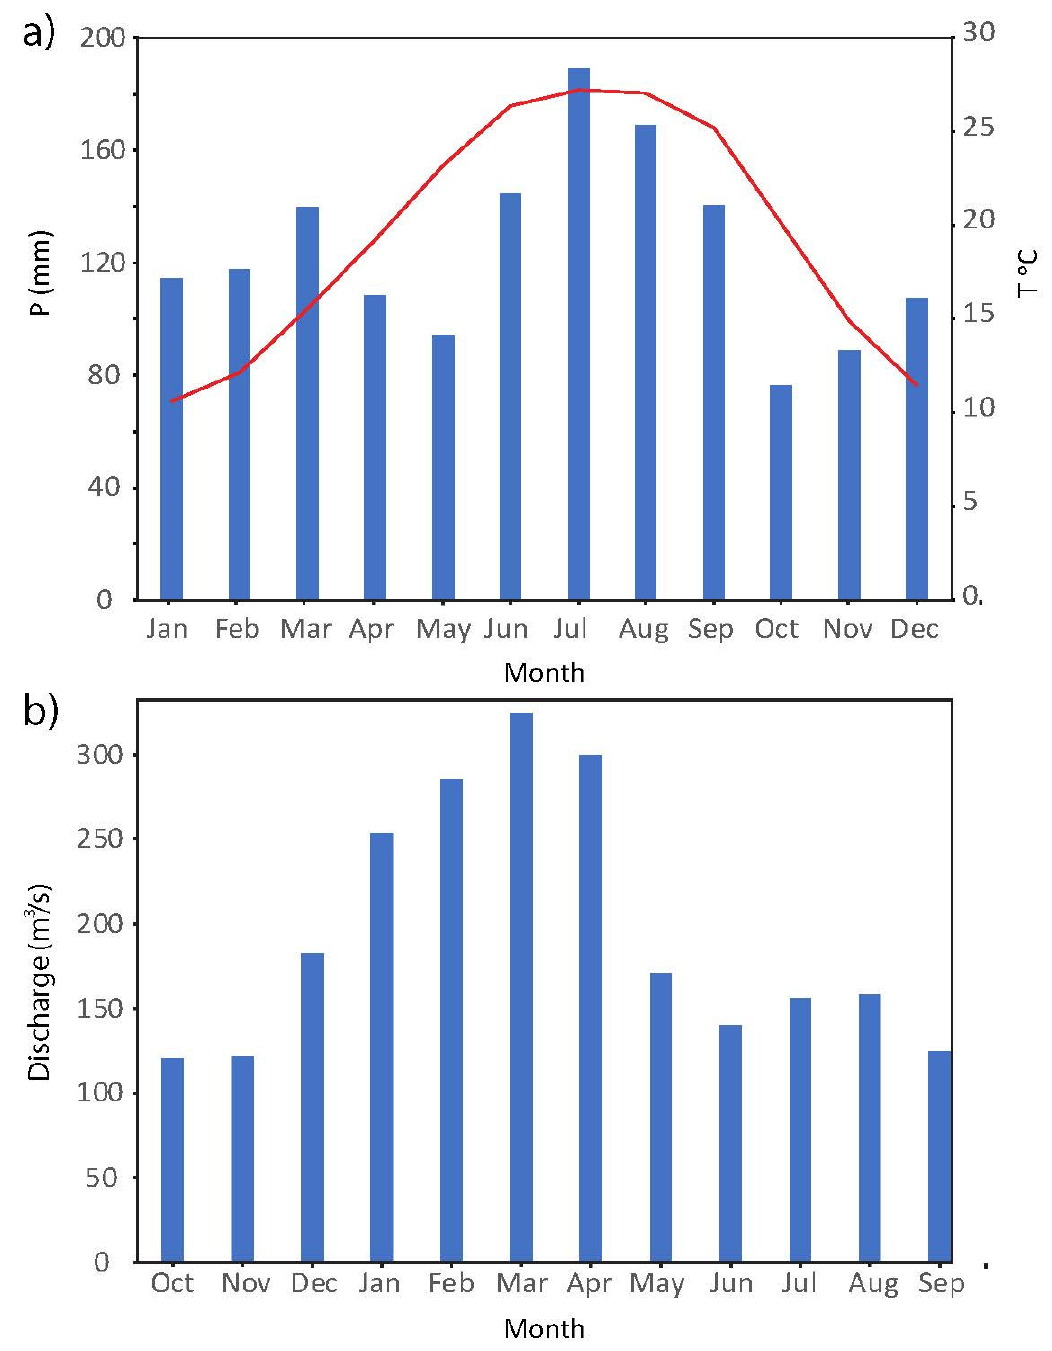
Figure A1. ( a ) Climograph showing Florida Division 1 [56] monthly mean precipitation ( blue columns ) in mm and monthly mean temperature ( red line ) in °C and ( b ) hydrograph showing Choctawhatchee River monthly mean streamflow (in cubic meters per second) at the USGS Bruce, Florida gage [27].